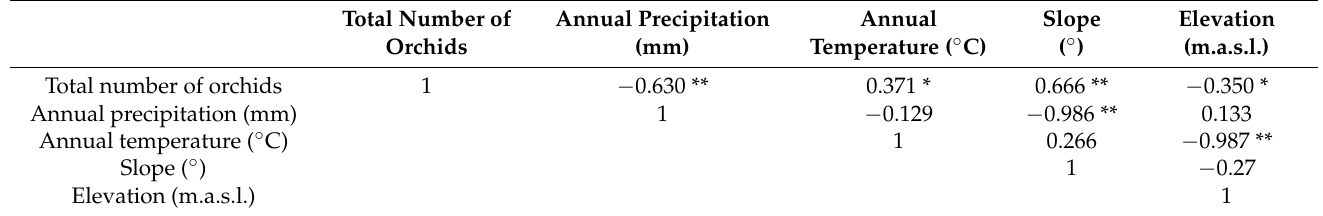
Table 1. Spearman’s rho correlation between annual temperature, annual precipitation, slope, eleva- tion and aspect with distribution and abundance of Paphiopedilum fairrieanum .